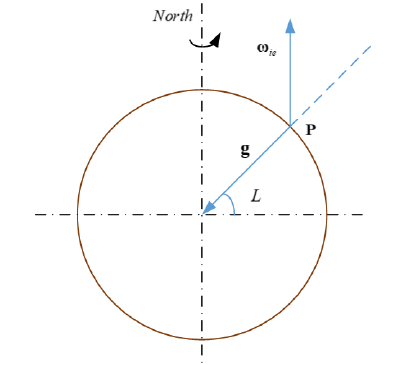
Figure 1. Representation of the latitude, local gravity acceleration vector and Earth rotation angular velocity vector at point